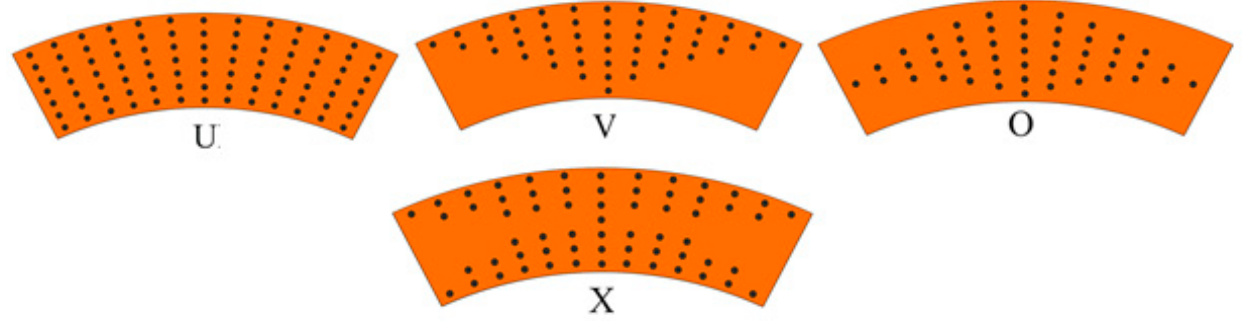
Figure 2. Distribution of volume fractions of CNTs across the thickness of the layer. The distribution of volume fractions of CNTs across the thickness of the layer are illustrated in Figure